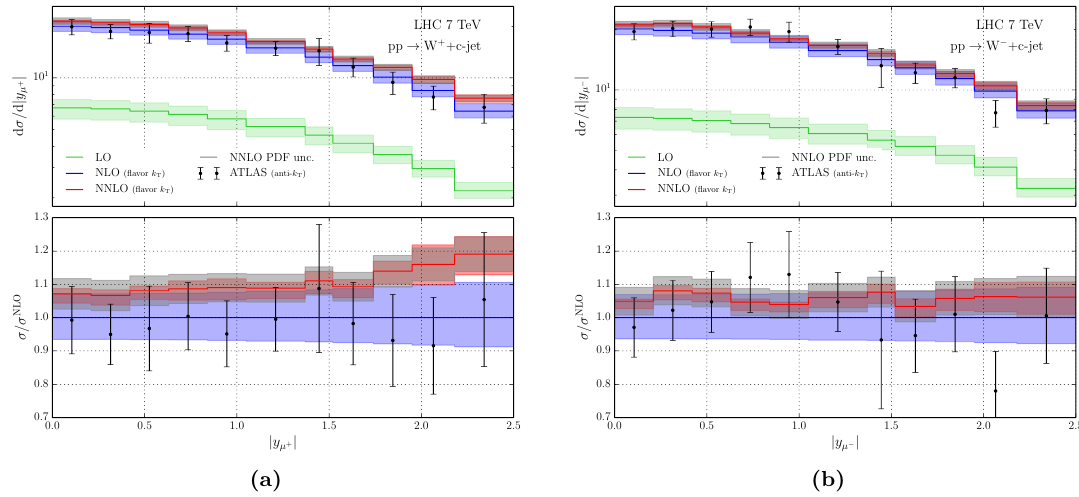
Figure 2. Differential distributions in the absolute rapidity of the anti-muon in the process √ pp → W + j (left) and of the muon in pp → W − j (right) at the LHC with s = 7 TeV. The upper c c panel shows the LO, NLO, and NNLO QCD absolute predictions along with ATLAS data [42]. The lower panel displays the same theoretical predictions and data relative to the NLO QCD prediction. The grey band represents the PDF variation at NNLO. The effect of V = 0 is included at Born cd 6 level only. The theory predictions are obtained using the flavor- k algorithm and the ATLAS data T has been measured using anti- k T